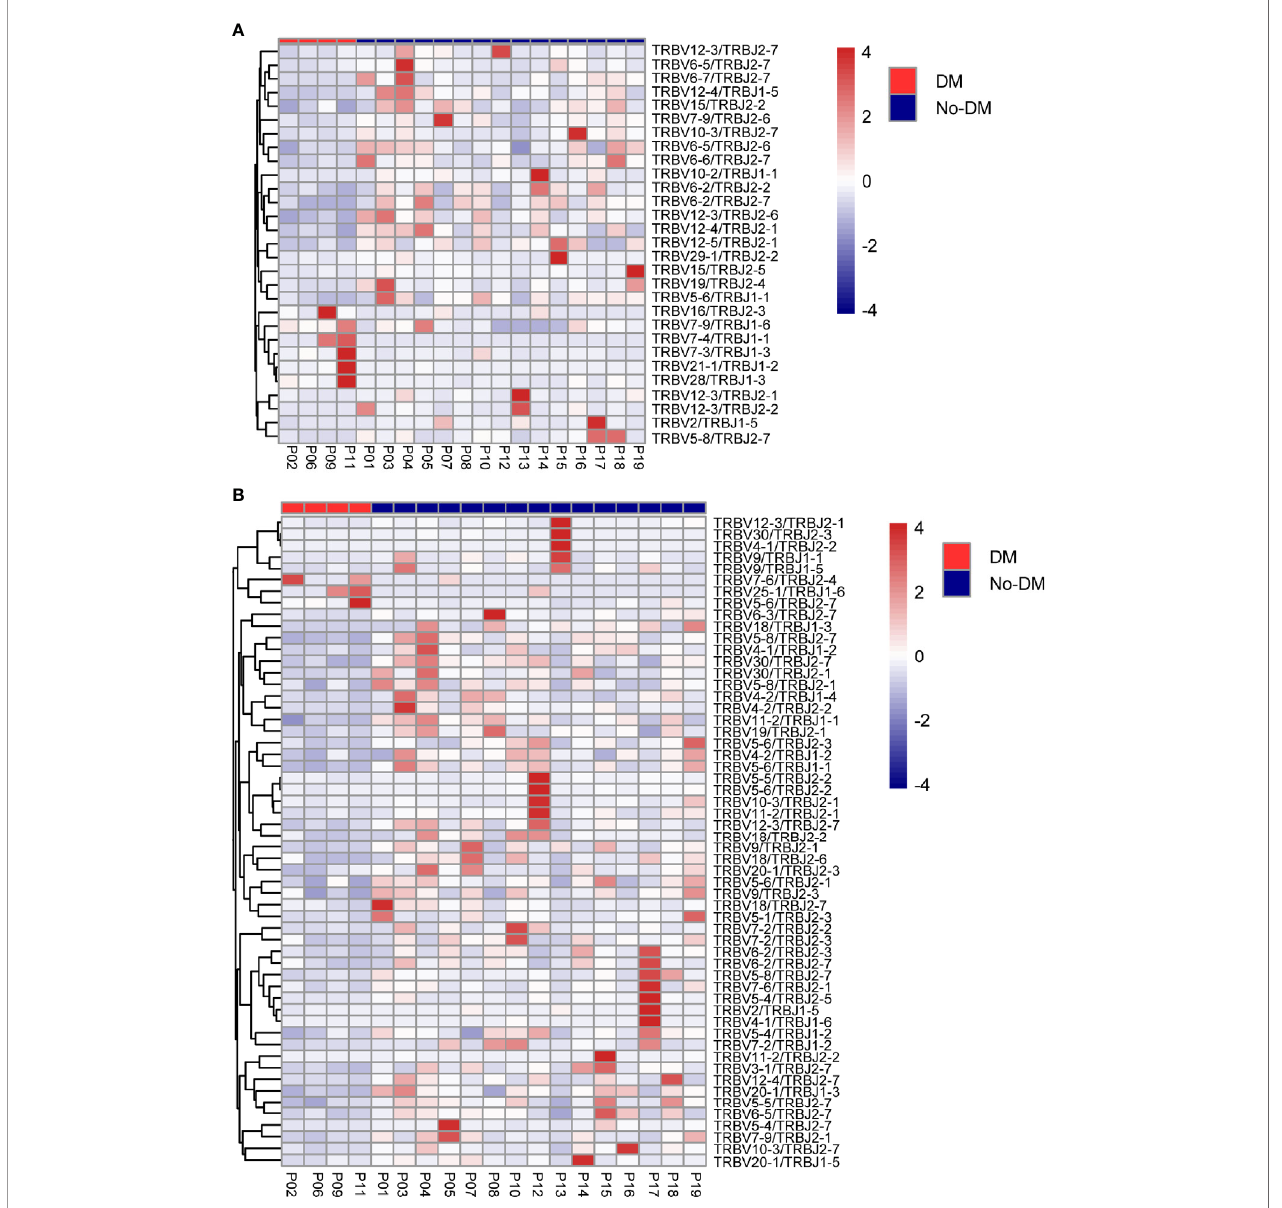
FIGURE 5 | Heatmaps of changes in V and J gene frequencies. (A) Heatmaps show signi fi cant differences in V-J paring patterns in samples obtained before SBRT according to whether patients did (red) or did not (blue) develop metastases after SBRT. (B) Heatmaps show signi fi cant differences in V-J paring patterns in samples obtained after SBRT according to whether patients did (red) or did not (blue) develop metastases after SBRT. Color-bar intensity re fl ects mean proportions of TCR repertoire in the with- or without-metastases